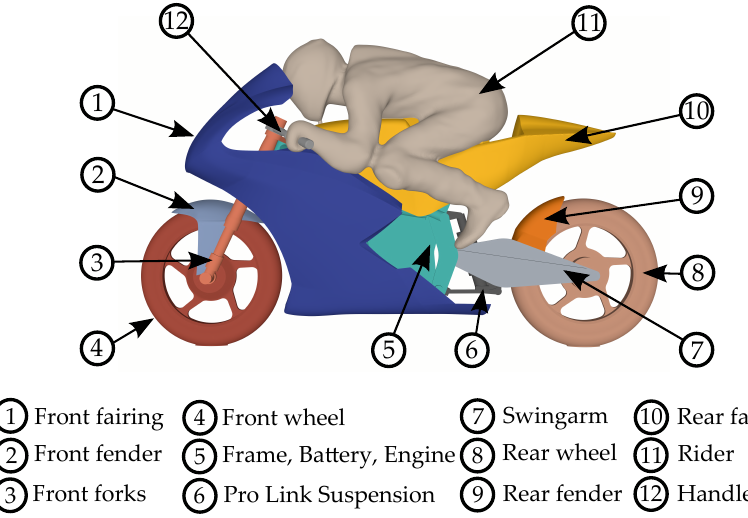
Figure 13. The studied geometry with its key components